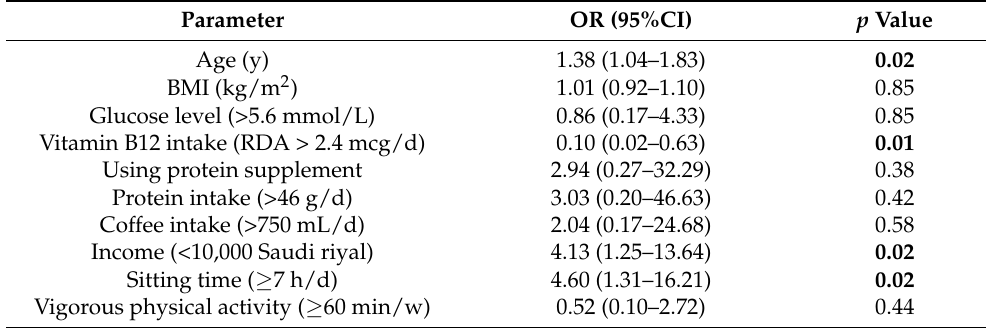
Table 2. Indicators of vitamin B12 insufficiency ( ≤ 220 pmol/L) among women of childbearing